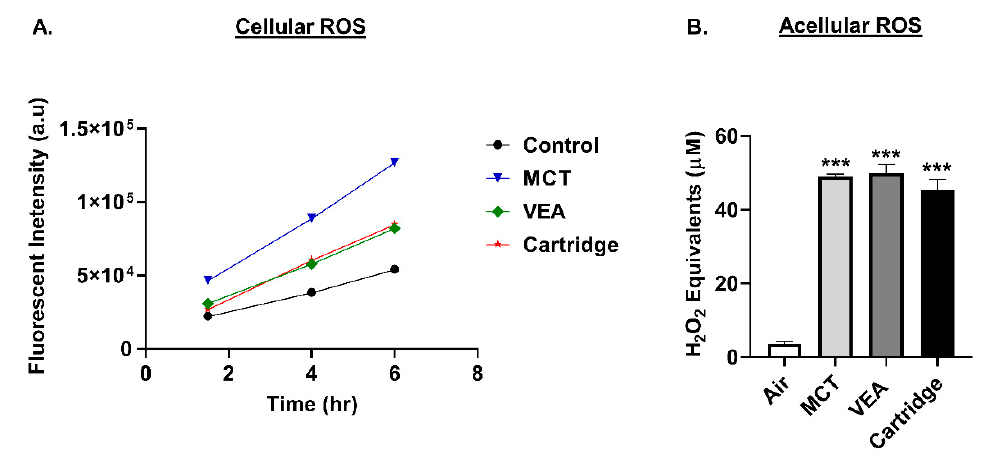
Figure 1. Increased cellular and acellular generation by medium-chain triglycerides (MCT), vitamin E acetate (VEA), and counterfeit cartridges. ( A ) Increased cellular ROS generation by cartridge liquid treatments. BEAS-2B cells were seeded at 15,000 / well. The following day, cells were treated with 20 µ M DCFH-DA in 1% FBS containing media for 30 min. Cells were then washed and treated with 0.25% ( v / v ) MCT, 0.025% ( w / v ) or 50 µ M Vitamin E acetate, and counterfeit vape cartridge liquids. Fluorescence (485,535 nm) was read at 1.5, 4 and 6 h post-treatment ( n = 4). Control vs. MCT *** p < 0.0001. Control vs. VEA * p < 0.05, Control vs. Cartridge p = 0.2236. ( B ) Increased acellular generation by MCT, VEA, and counterfeit vape cartridges. Air, 50% ( w / v ) vitamin E acetate, MCT, and counterfeit vape cartridges were bubbled through dichlorofluorescein diacetate (DCFH-DA) dye with two 70 mL pu ff